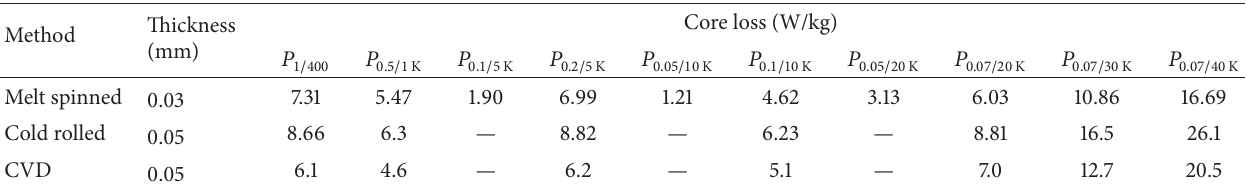
Table 3: Core losses of melt spinned ribbons compared with ribbons from cold rolling and